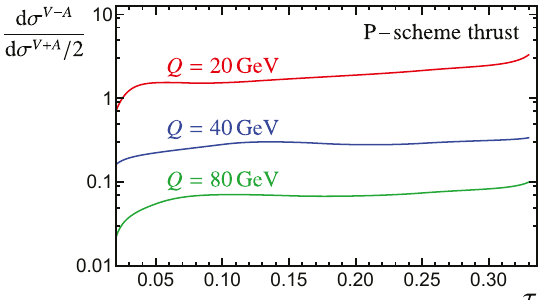
Figure 10 . Di(cid:11)erence between the vector and axial-vector di(cid:11)erential cross sections normalized to the average of the two currents. We show results for Q = 20 GeV (red), Q = 40 GeV (blue) and Q = 80 GeV (green).